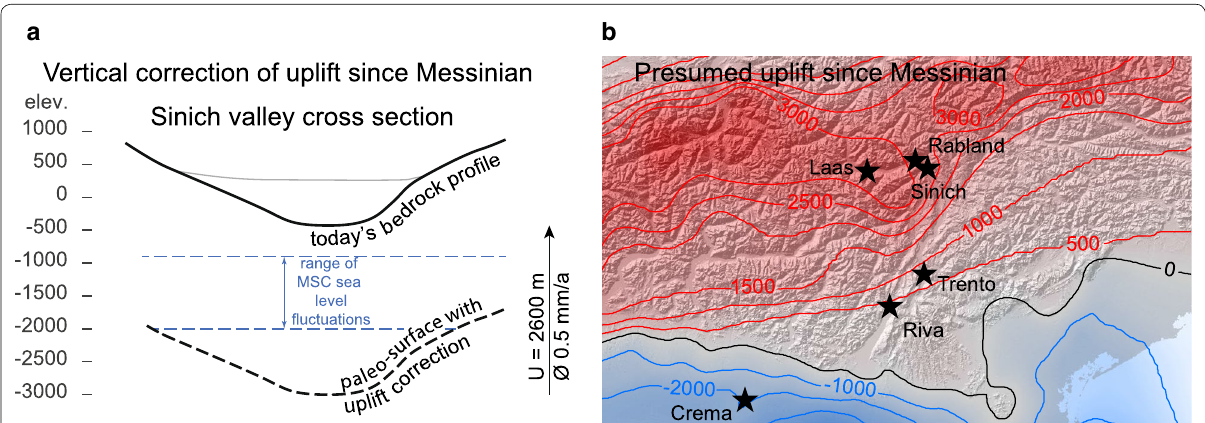
Fig. 9 a Incision profile restored for rock uplift since the Messinian (schematic). The lower sea level during the Messinian Salinity Crisis (MSC) is estimated between 900 and 2000 m (Clauzon 1982; Ghielmi et al. 2013; Hsü et al. 1973). Average uplift rate is 0.5 mm/a. Note, that the shape of − − the paleo-valley flanks are unknown. b Amount of total accumulated uplift assumed in this study, red is uplift and blue is subsidence. The range of MSC sea levels shows that river incision during MSC and the amount of uplift are